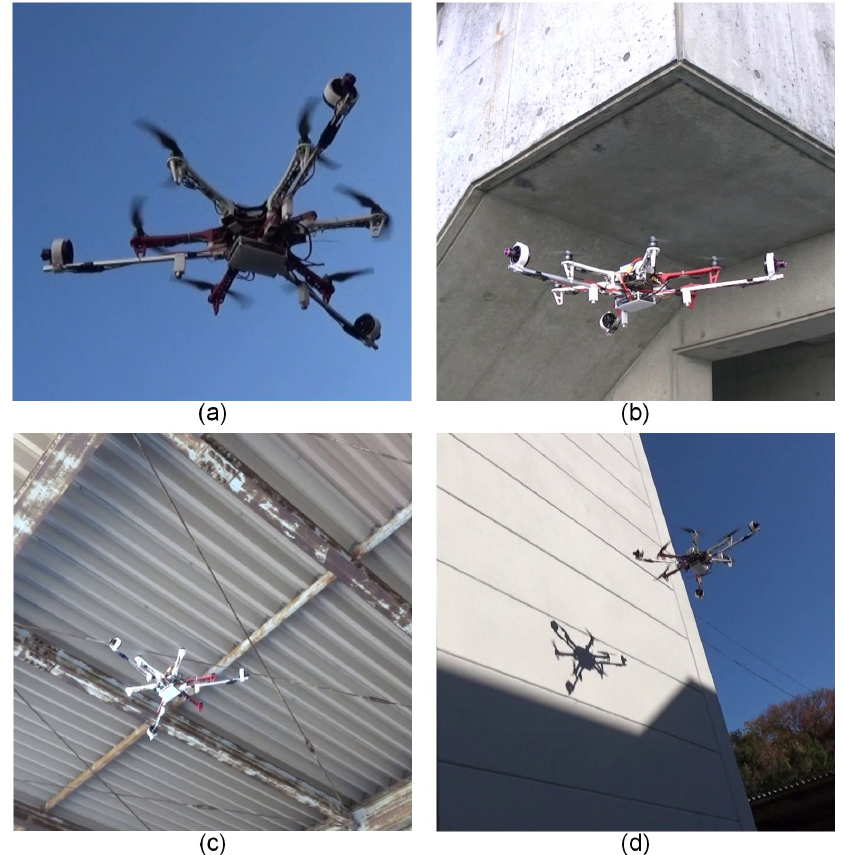
Figure 1. Add-on planar translational driving system (ATD) with the multirotor: ( a ) the overview of ATD with multirotor; and ( b – d ) the case of assuming some aerial manipulation task in narrow region, roof, and wall